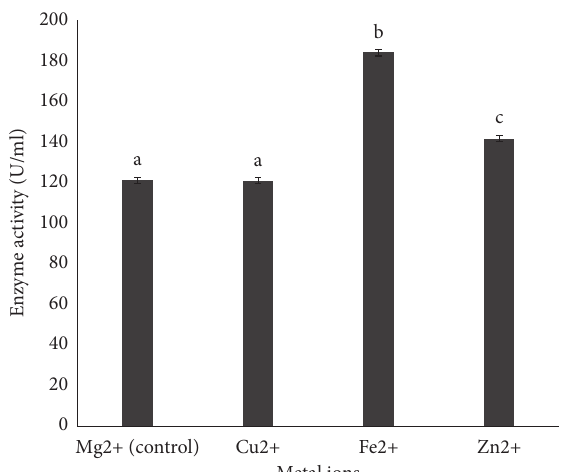
Figure 6: Effect of metal ions on dextranase production from Talaromyces sp. at the second day of fermentation. Symbols (mean ± SE, n � 6) having similar letters are not significantly different from each other ( Bonferroni , P < 0 . 0125).